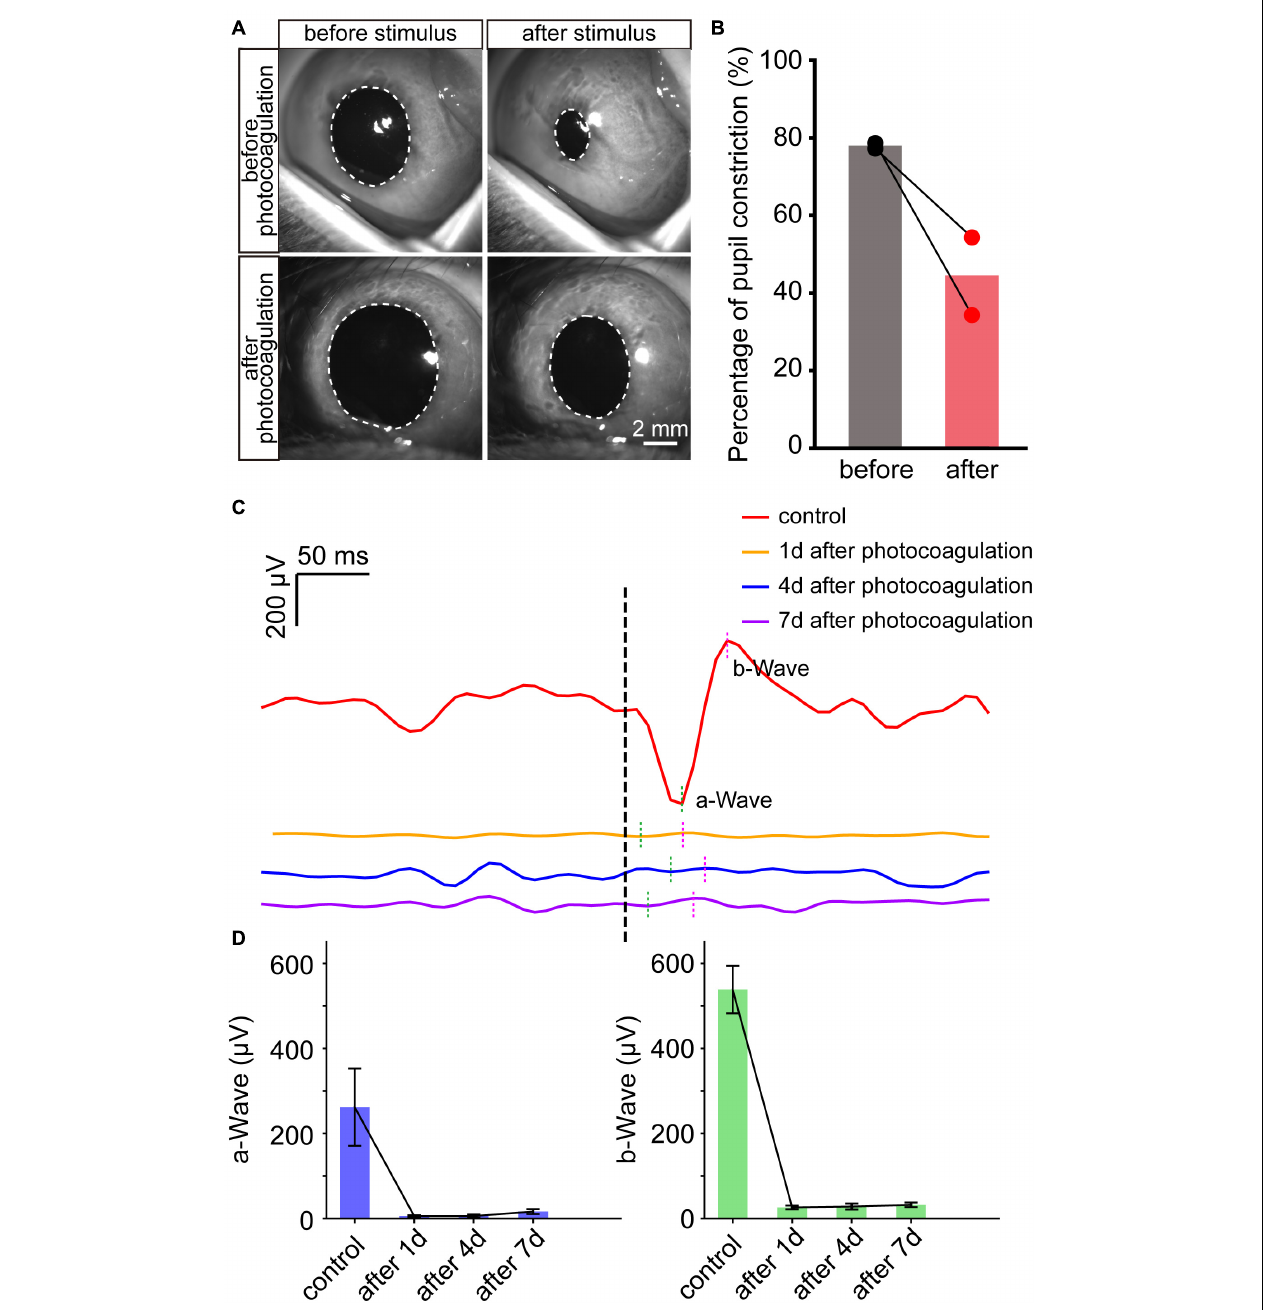
FIGURE 6 | The change of pupillary light reflex and ERG in rabbits before and after photocoagulation. (A) The example images of pupillary direct light reflex before (top row) and 3 days after photocoagulation (bottom row) of the same rabbit eye. The position of the white dotted circle is the pupil position. Scale bar = 2 mm. (B) Pupil constriction ratio before and 3 days after photocoagulation of rabbits. The pupil constriction ratio is calculated as (S 0 -S min ) / S 0 × 100%, S min is the minimum pupil area under light stimulation, and S 0 is the pupil area of the frame before light is given. (C) Sample waveforms of ERG before photocoagulation, 1, 4, and 7 days after photocoagulation. (D) Comparison of a- and b-wave amplitudes in eyes before photocoagulation and 1, 4, and 7 days after